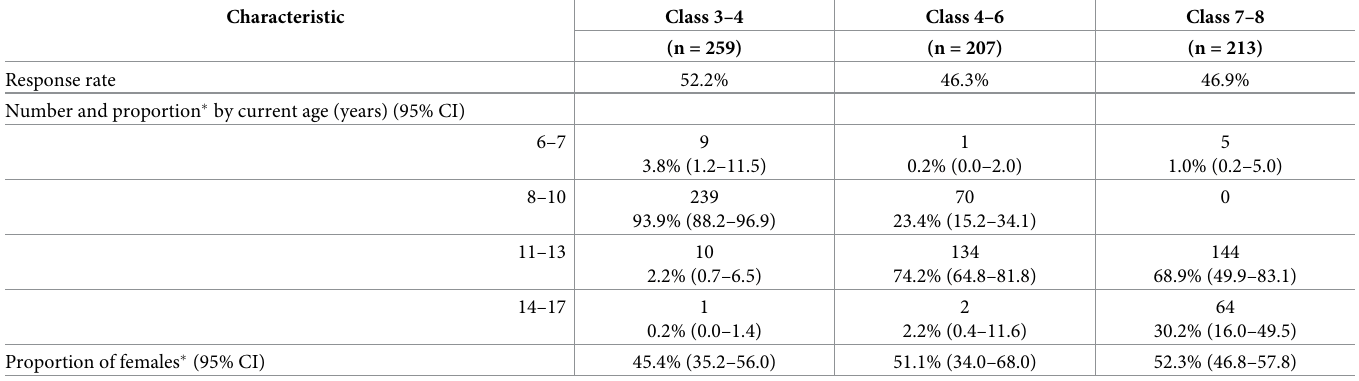
Table 3. Demographic characteristics of class 3 and 8 students in the Eastern Divisions of Fiji,